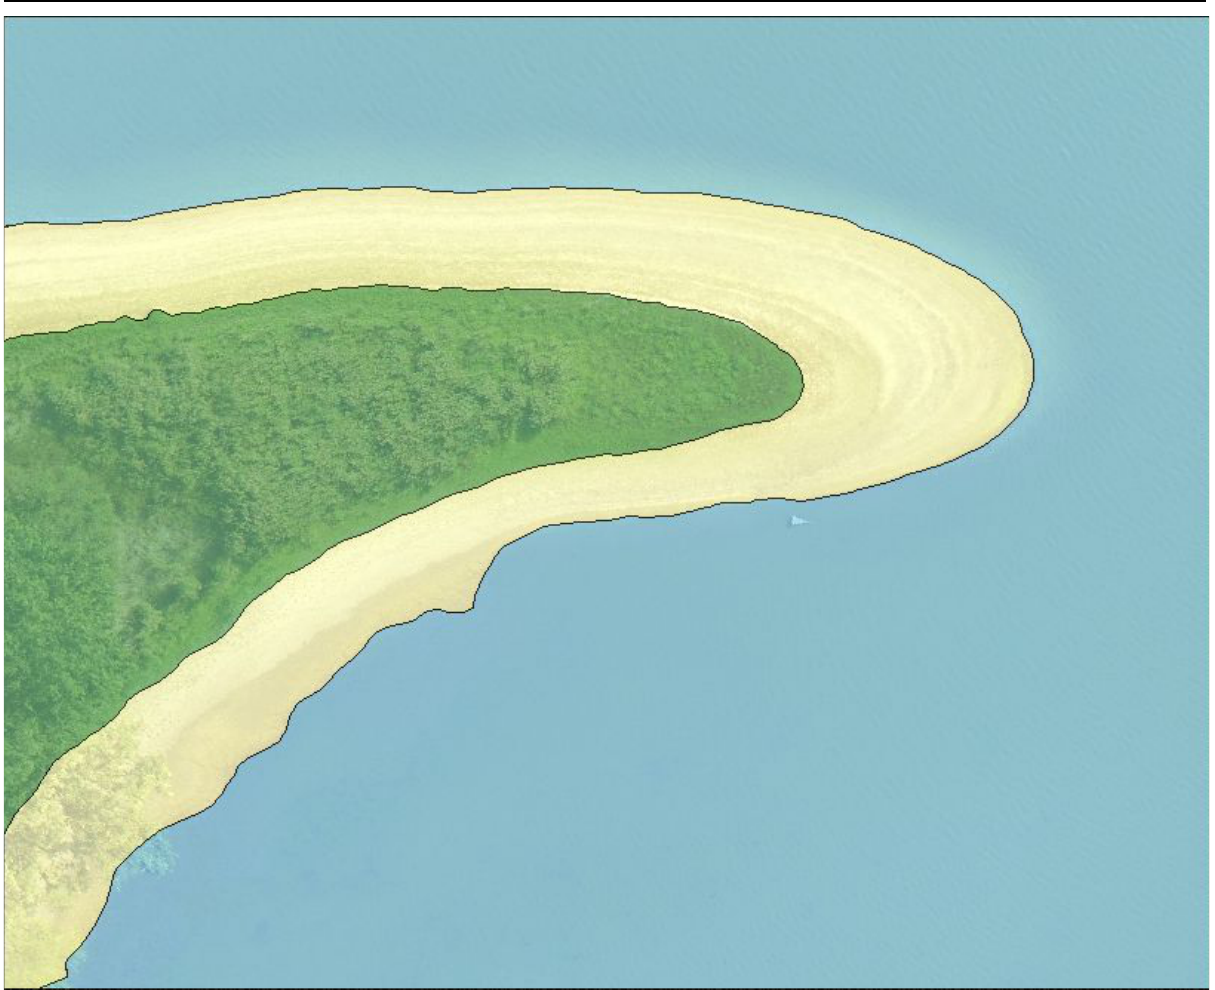
Figure 6. Example of digitalization of the August time